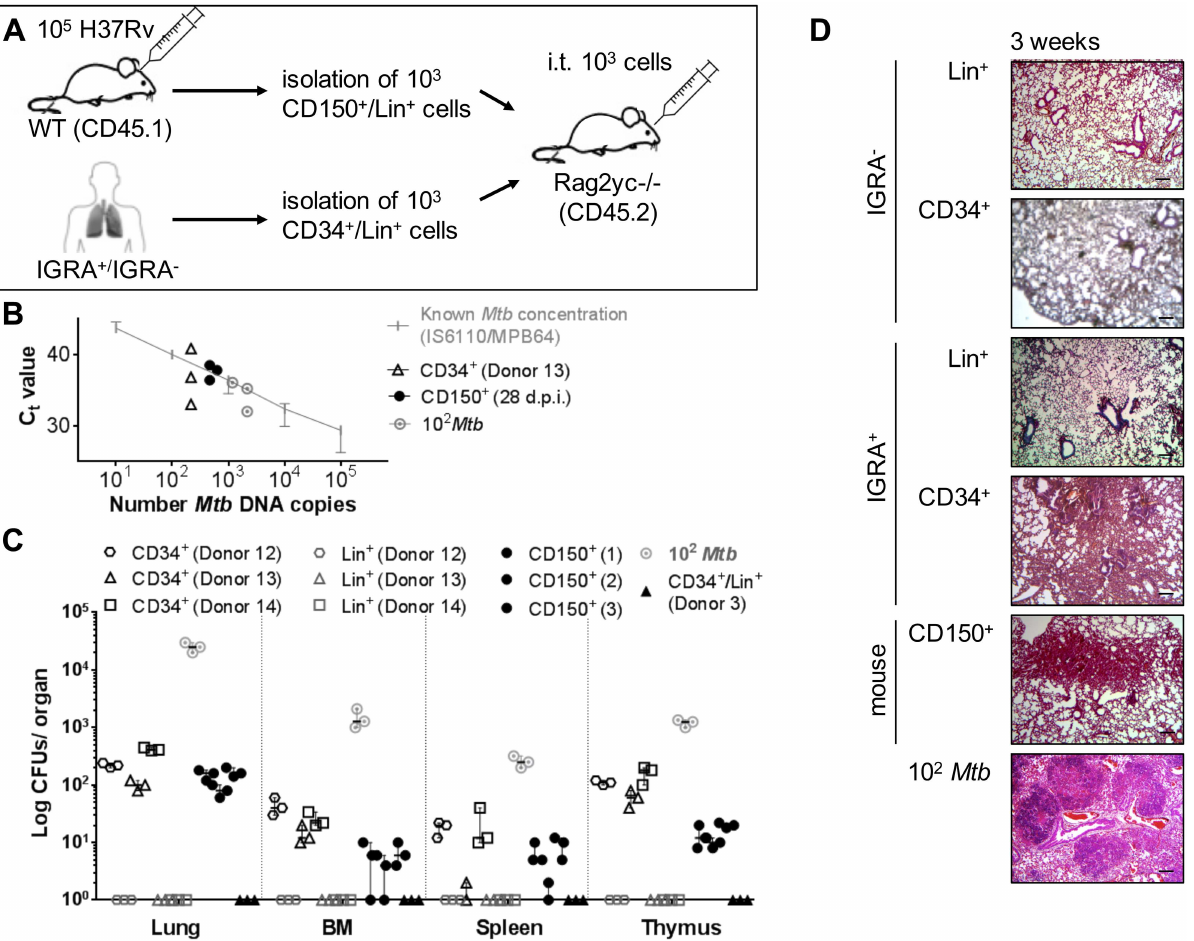
Fig 6. Intratracheal transfer of Mtb infected human and murine pHSCs leads to Mtb growth and increased cellularity into the lungs in transplanted hosts. (A) Injectionof Lin - CD34 + and Lin + cells from blood of IGRA + human donors(Donor 12–14)and mouse LT-pHSCs from bone marrow 28 days p.i. into the trachea of Rag2 –/– Il2rg /– mice (3 mice/population). Transfer of 10 2 CFUs Mtb was used as positive (n = 3), uninfectedpHSCs and Lin + cells of an IGRA − donor (Donor 3; n = 1) as negative,control. Recipients were analyzedafter 3 weeks. (B) Monitoringof Mtb infectionby TaqMan PCR using probesthat target MPB64 and IS6110 together on genomicDNA of 10 5 lung cells 3 weeks upon transfer. PCRs were performed in technicaltriplicates and normalized to murineGAPDH. (C) CFU Mtb growth on Middlebrook7H11 agar in cells of lung, spleen,thymus and non-separated, 10 5 bone marrow cells 3 weeks upon transfer (n = 3/population). Shownare data from 3 independentexperiments. (D) Histopathology of representative lung sections 3 weeks upon transfer. Lungswere stainedwith hematoxylin/eosin, screenedwith 5 × objectives and verifiedusing a light microscope. Shown are representative data from 3 independent experiments. Data are shown as median+ interquartile. Scale bar: 100 μ